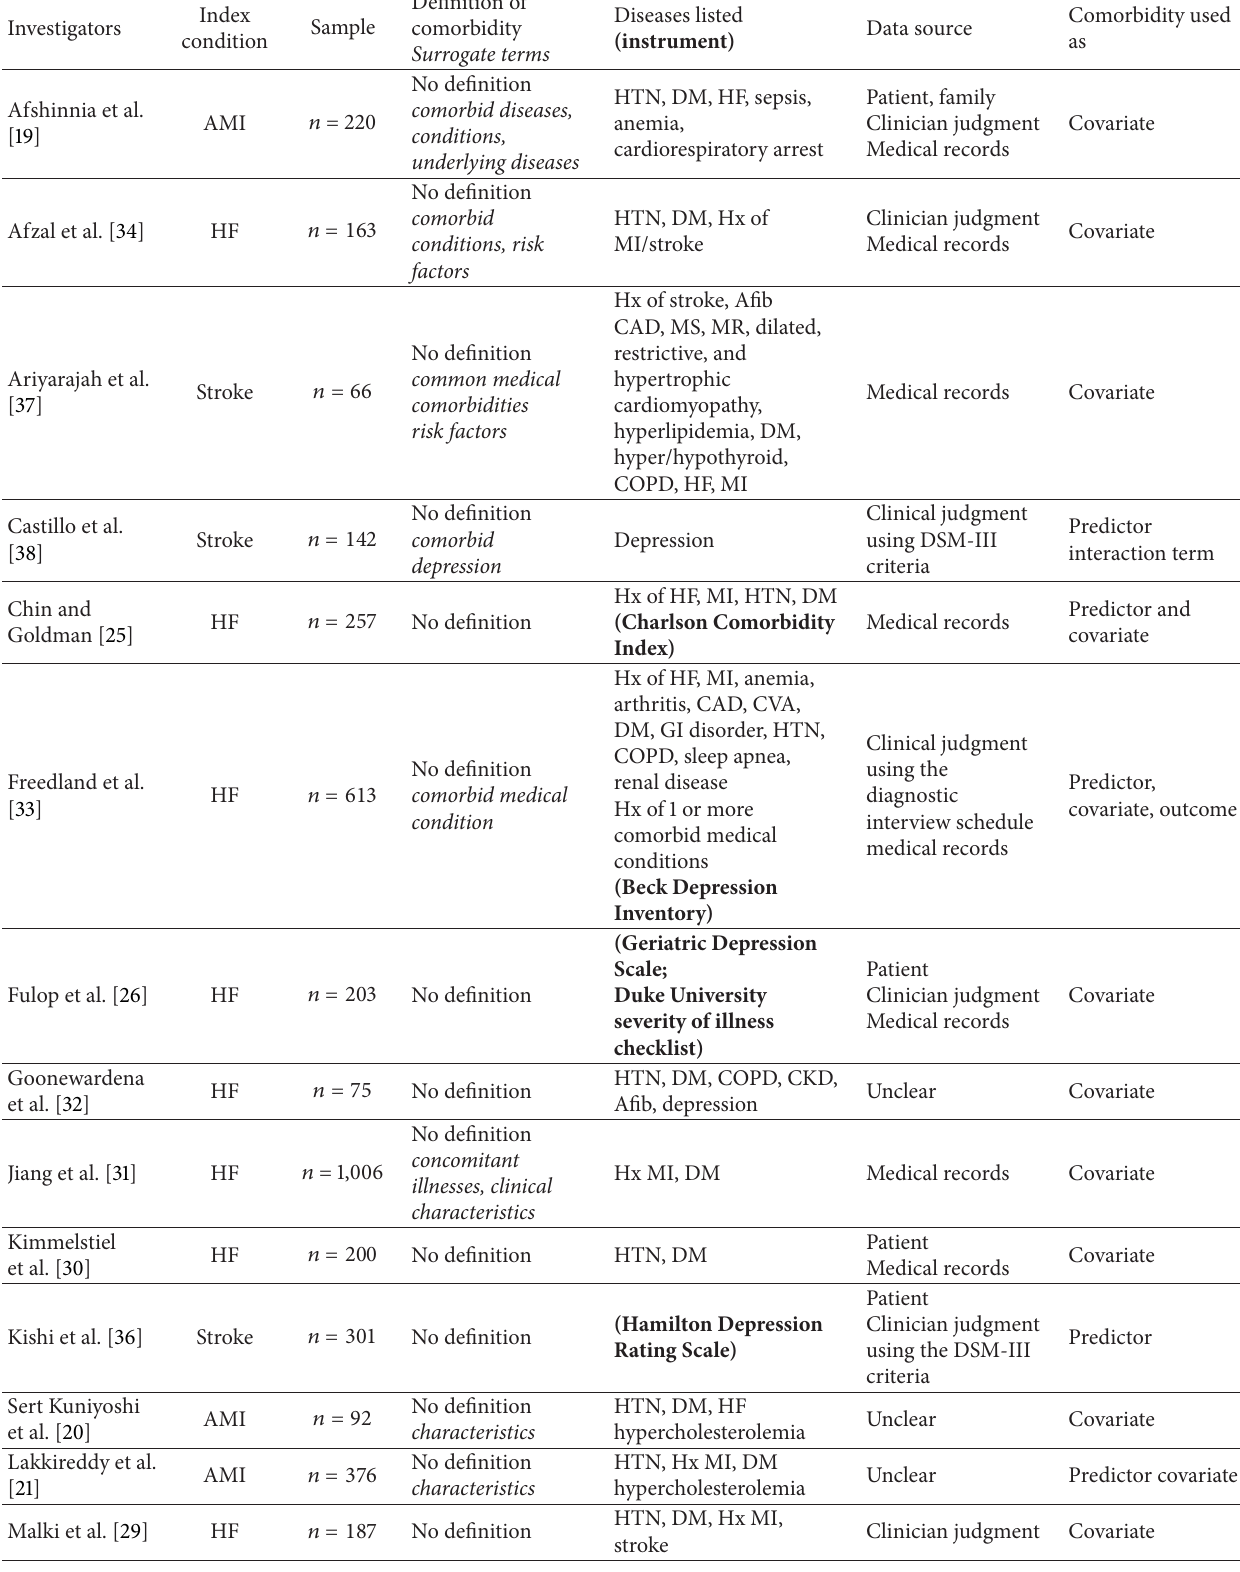
Table 3: Studies in final